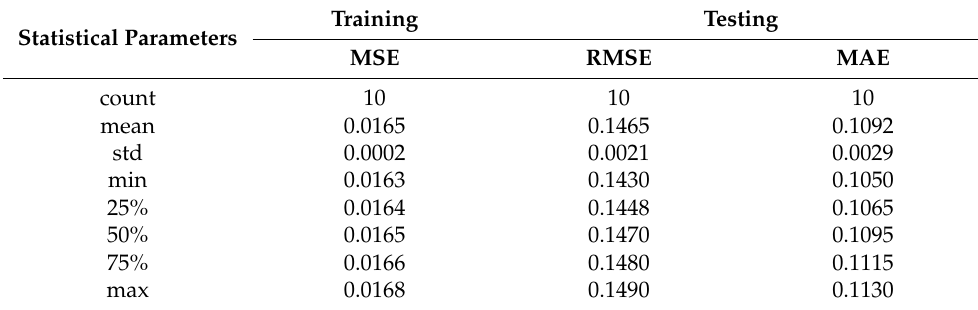
Table 17. Statistical analysis of RDM-2 architecture. Statistical